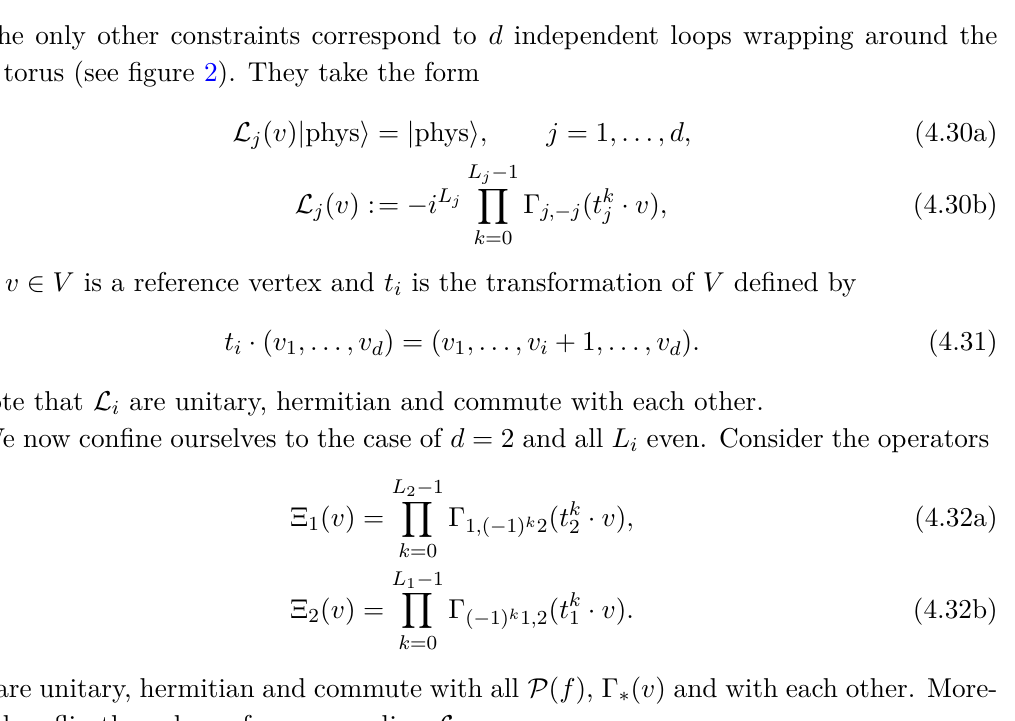
Figure 2 . Two loops wrapping the 2 -dimensional